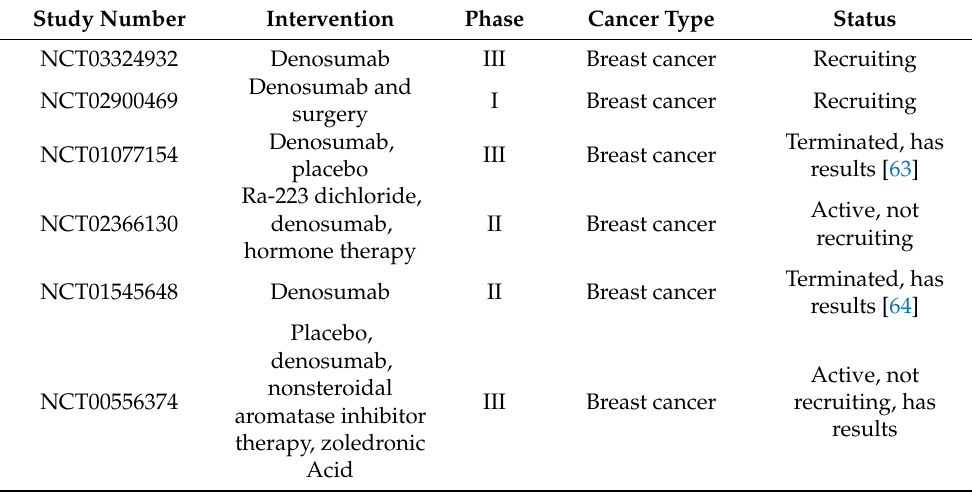
Table 1. Clinical studies with denosumab for breast cancer